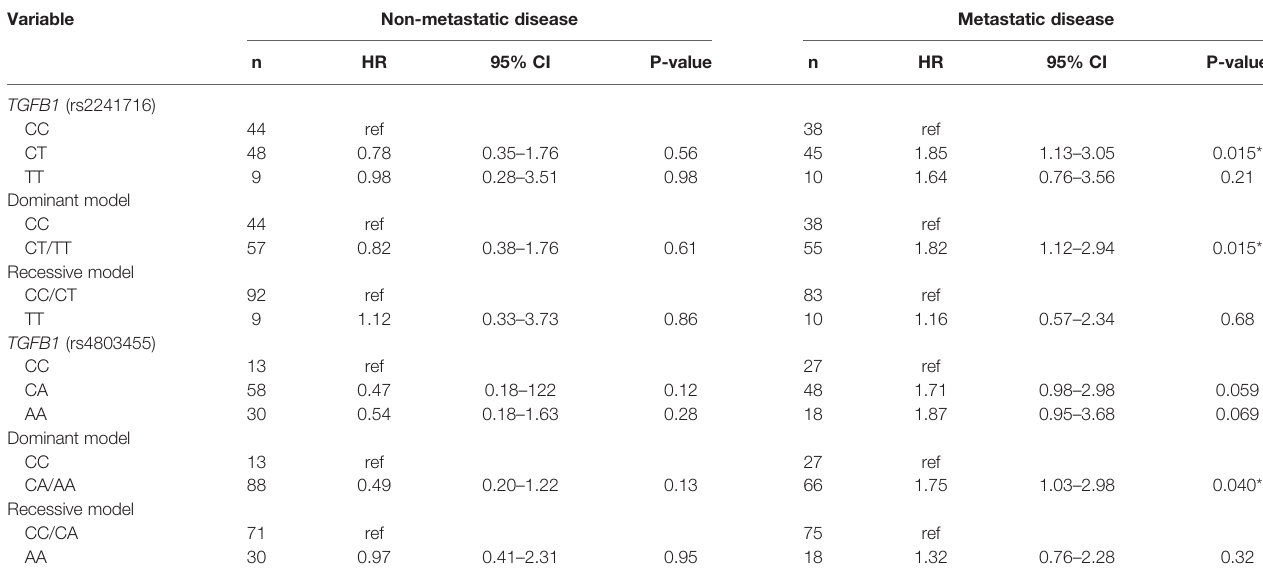
TABLE 3 | Progression-free survival according to TGFB1 polymorphisms.